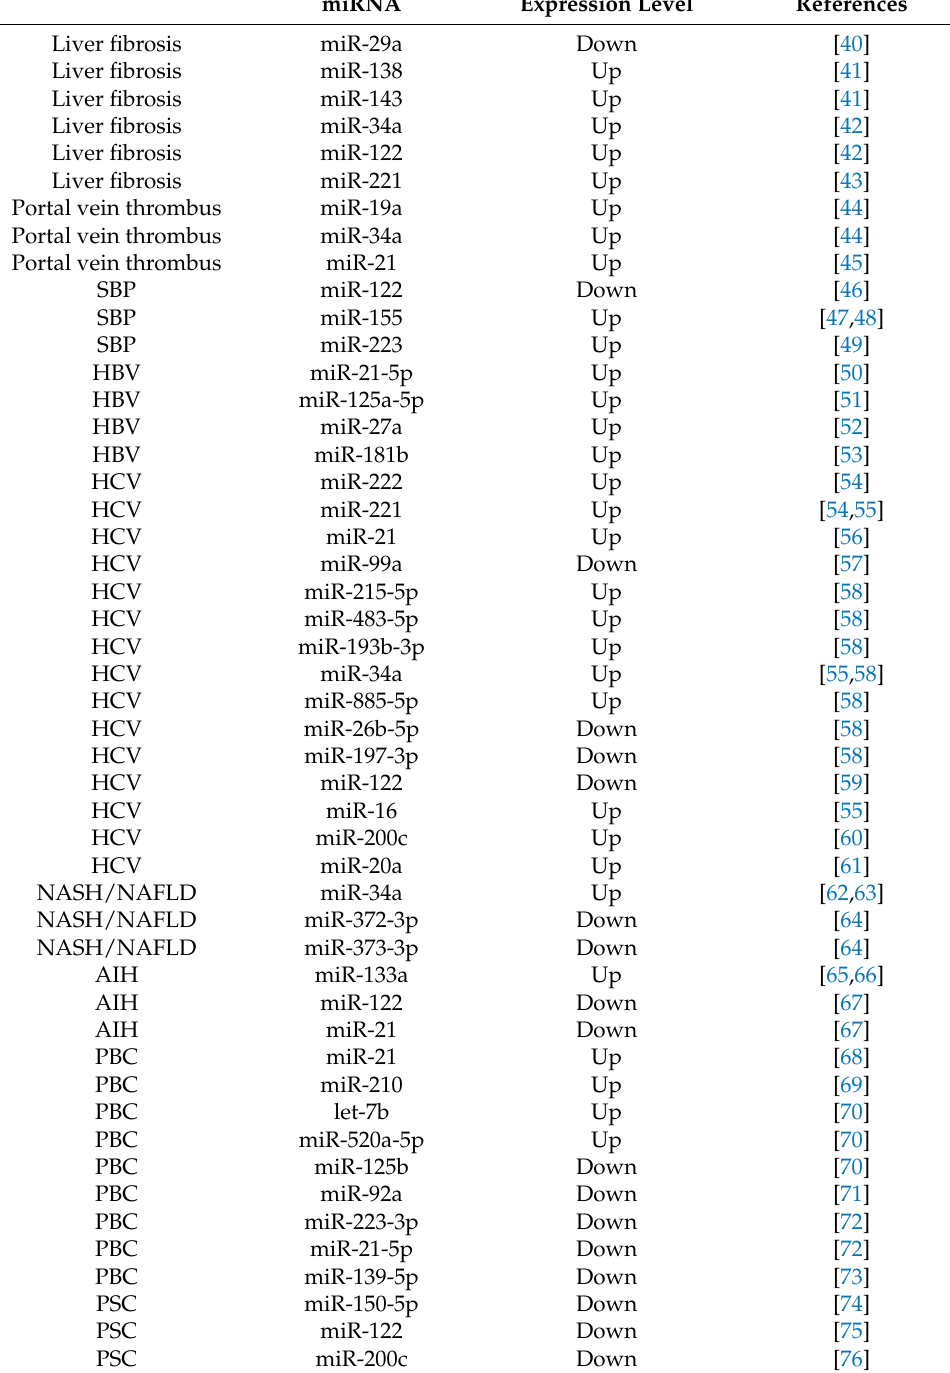
Table 1. miRNA as biomarker of liver